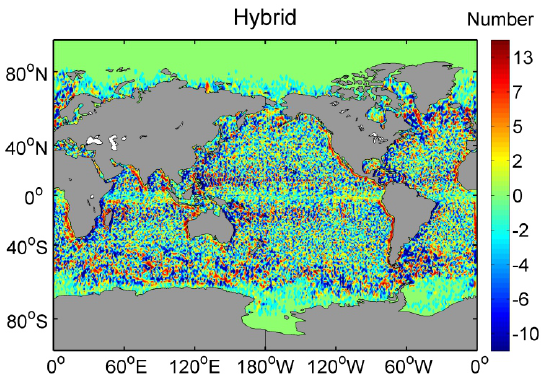
Figure 15. Geographical distribution of the sources and sinks of eddies with lifespans longer than 10 days tracked by the hybrid method in each 1 ◦ × 1 ◦